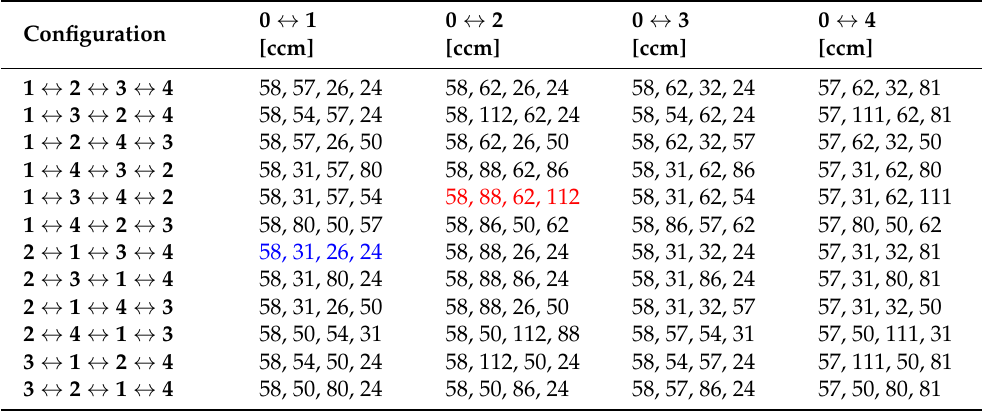
Table 4. Necessary displacements for linear VDN topology interconnection schemes in crane applica- tion. The Blue colored case marks the scheme with the lowest displacement sum and the red colored cases mark the scheme with the highest displacement